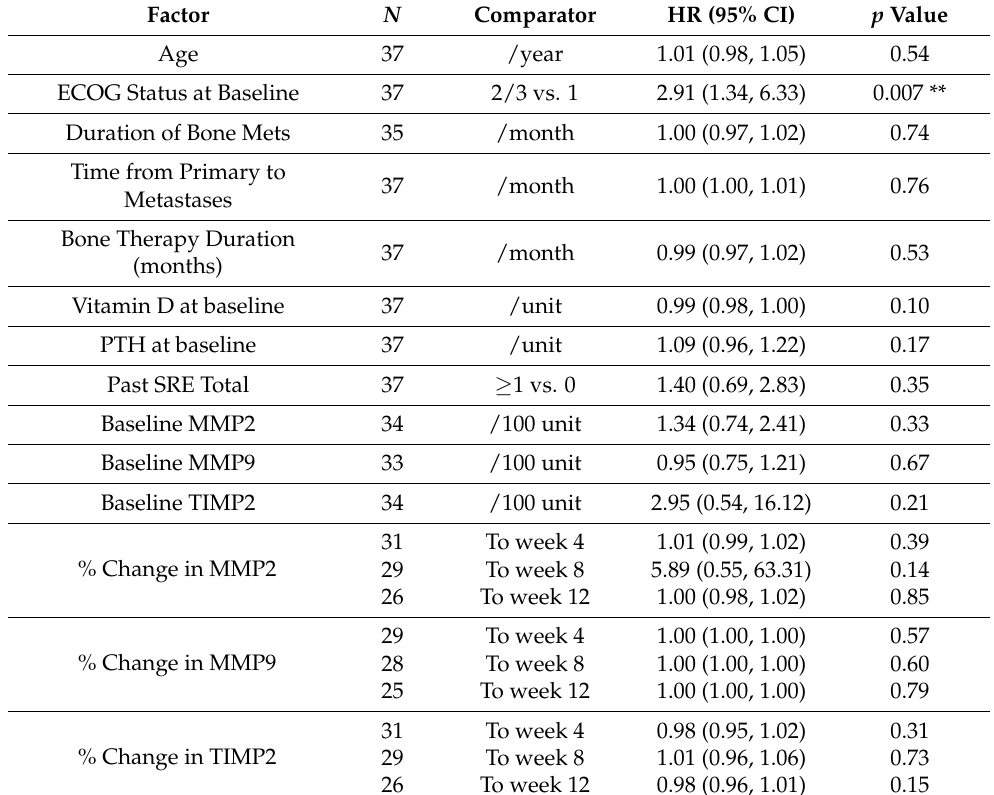
Table 6. Cox regression for prognostic factors of overall survival.